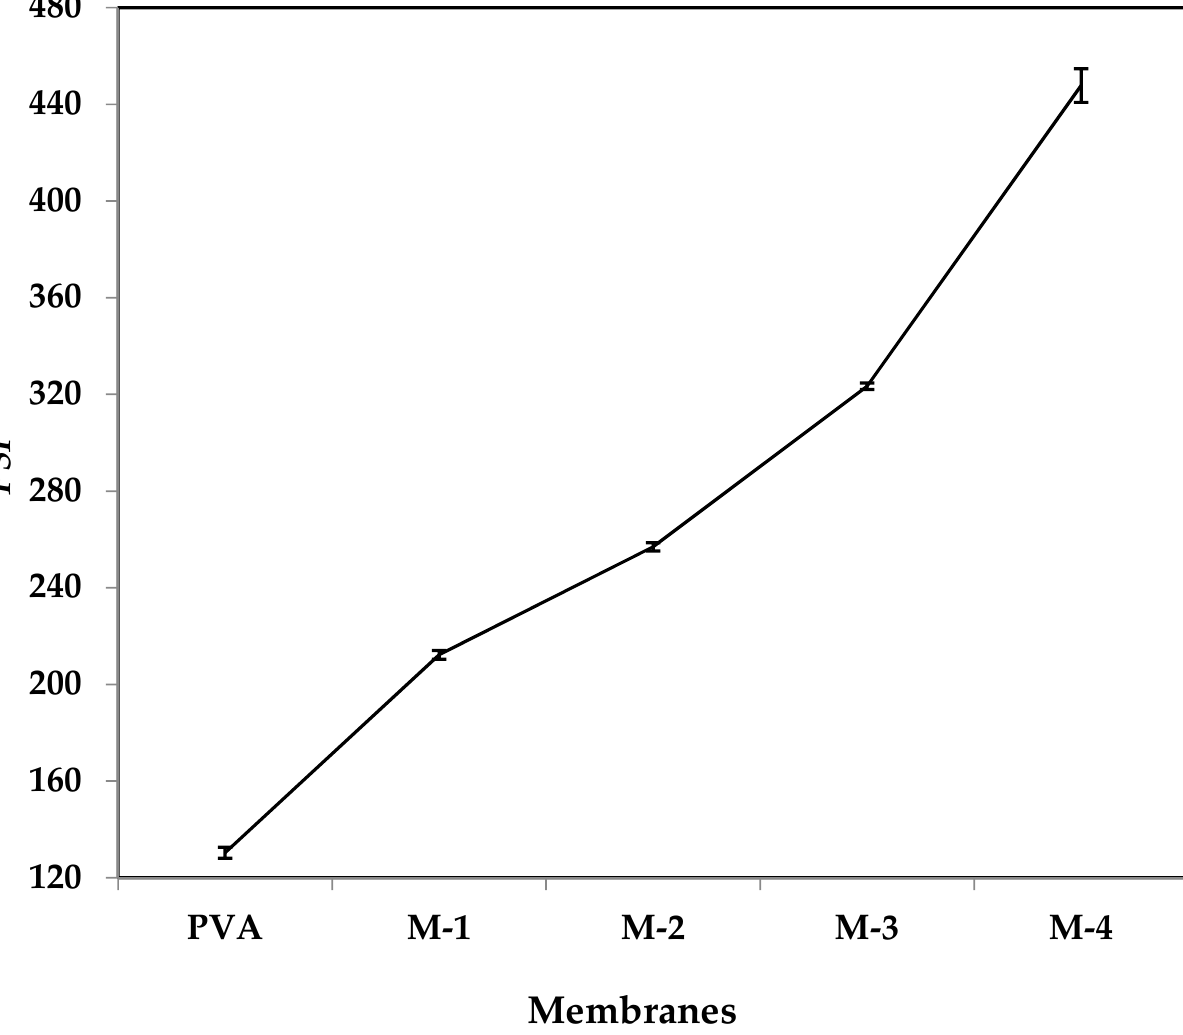
Figure 9. Effect of CS-capped AgNP content on PSI at 30 °C.